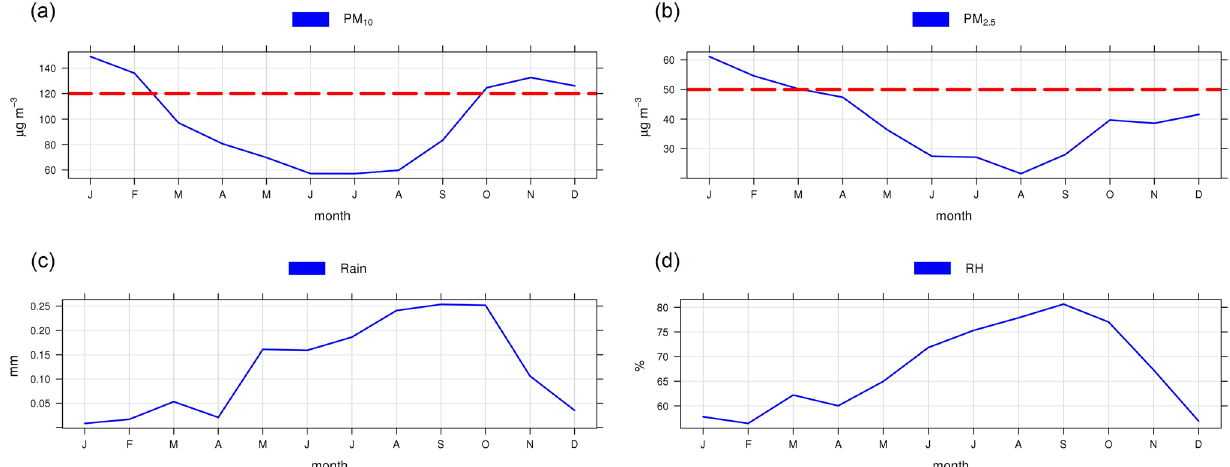
Figure 2. Intra-annual variations of ( a ) PM 10 , ( b ) PM 2.5 , ( c ) rain, and ( d ) RH (relative humidity) (the dash line is the 24-h NAAQS of PM 10 and PM 2.5